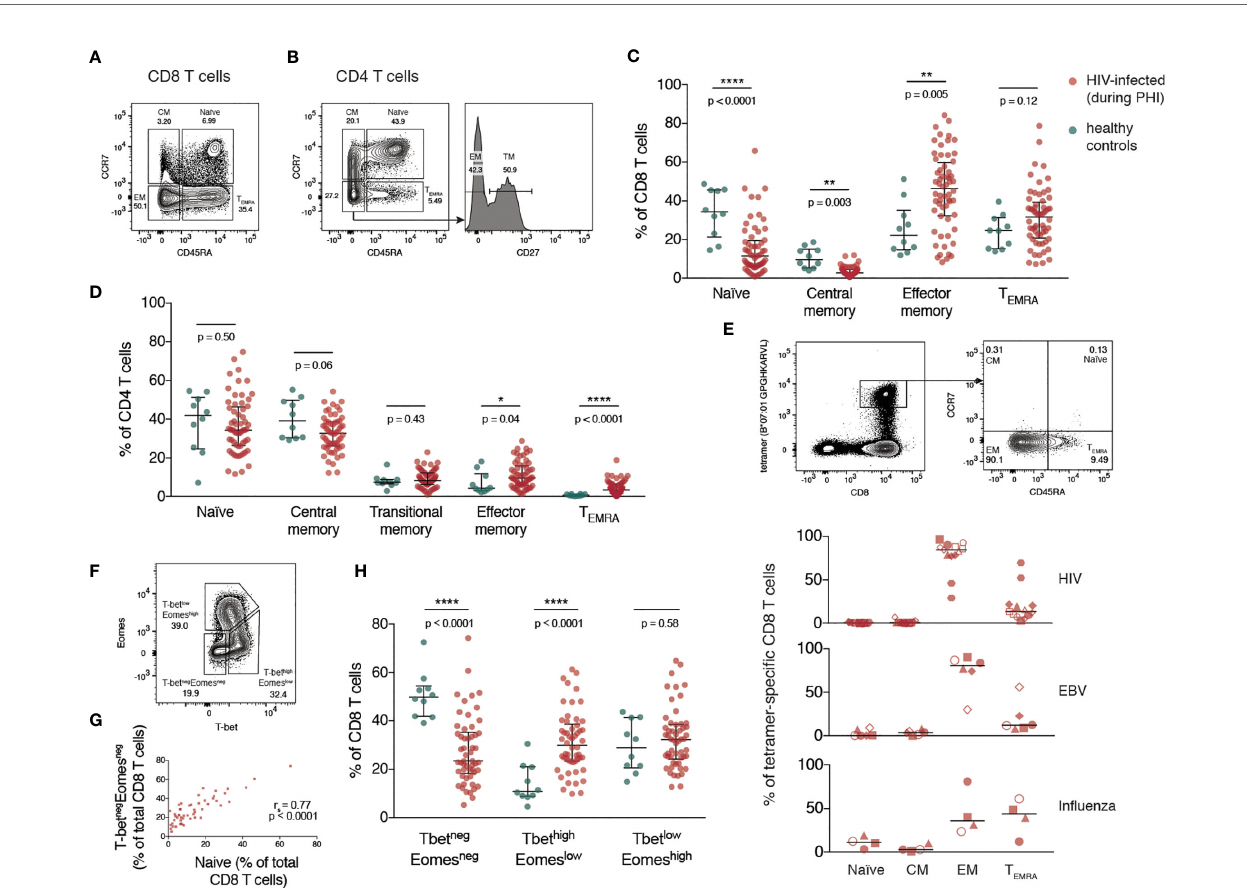
FIGURE 1 | Expansion of differentiated CD4 and CD8 T cells during primary HIV infection. (A) Representative gating of CD8 T cell memory subsets. (B) Representative gating of CD4 T cell memory subsets. The percentage of T cells comprising each memory subset is shown in (C) (CD8 T cells) and (D) (CD4 T cells) for healthy individuals (n = 10; green) and HIV-infected individuals during PHI prior to ART (n = 60; red). Groups were compared using a Mann-Whitney test. (E) Memory phenotype of HIV, EBV and in fl uenza-speci fi c CD8 T cells from individuals (n = 9) during PHI. The panels on the top show representative HIV tetramer staining. Symbol shapes indicate tetramers from the same individual. EBV and in fl uenza tetramers were not available for all individuals; for some individuals multiple different HIV tetramers were used and these are shown as separate data points. (F) Representative gating from one donor during PHI shows the division of CD8 T cells into 3 populations: T-bet neg Eomes neg , T-bet high Eomes low and T-bet low Eomes high . (G) The frequency of T-bet neg Eomes neg and naïve CD8 T cells are plotted (n = 51); data were tested using a Spearman correlation. (H) The frequency of each of T-bet neg Eomes neg , T-bet high Eomes low and T-bet low Eomes high populations in healthy controls (green; n = 10) and during PHI (red; n = 54) is shown. Groups were compared using a Mann-Whitney test. For all panels, bars indicate median and interquartile range. * indicates p < 0.05; ** indicates p < 0.01; **** indicates p <